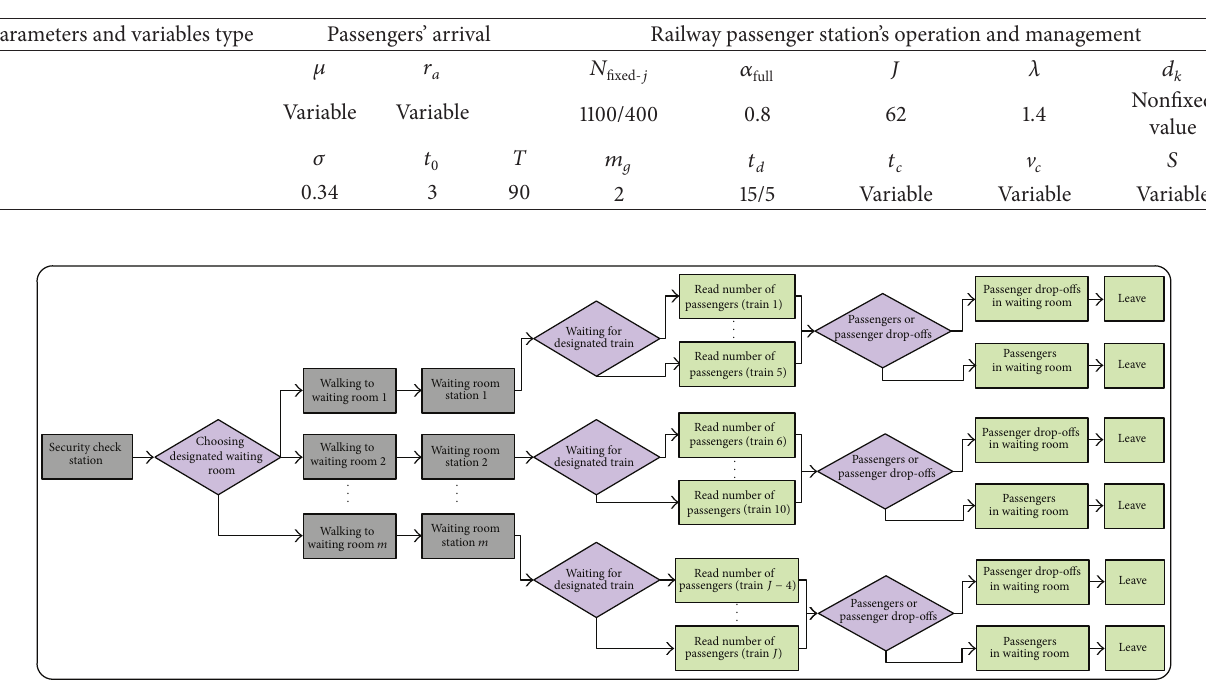
Table 4: Values of simulation parameters and variables.